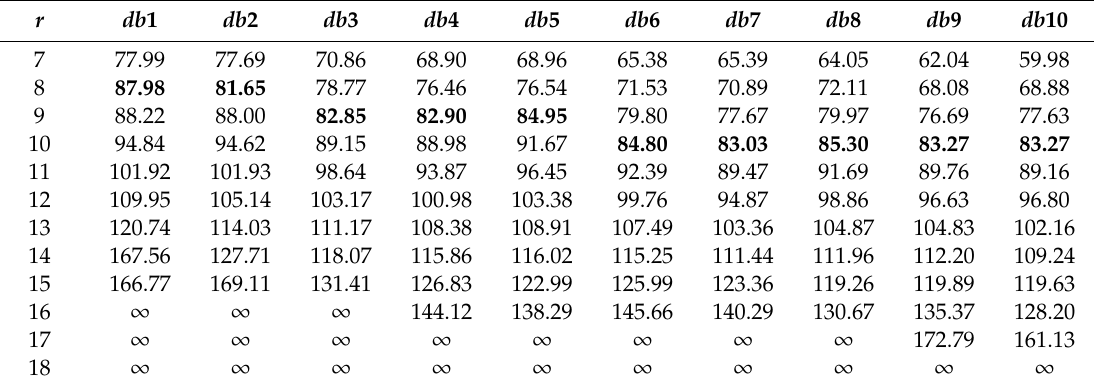
Table 17. Experimental results ( PSNR , dB) of 3D tomographic 16-bit image “Body_1.0” DWT by using bit-width r of Daubechies wavelets filters coe ffi cients.